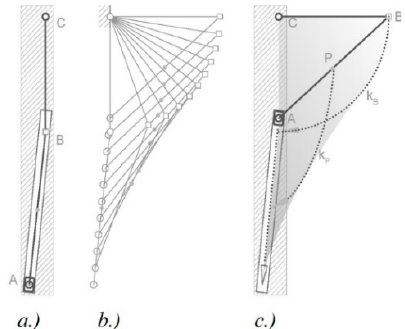
Fig. 7 Kinematics of a Bi-fold Door a) closed Position, b) Construction of folding Geometry, c) open Position with Envelope and Movement paths of two